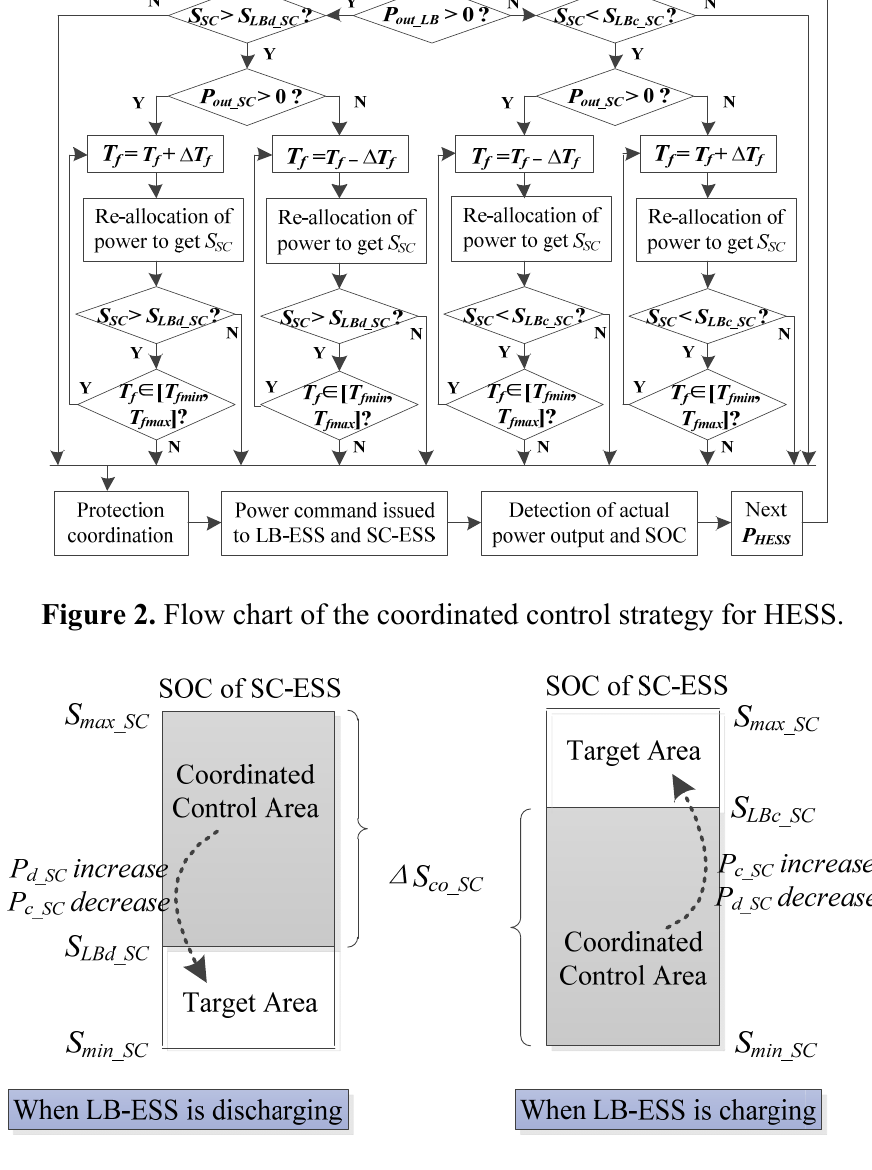
Figure 3. Coordination control diagram of overall